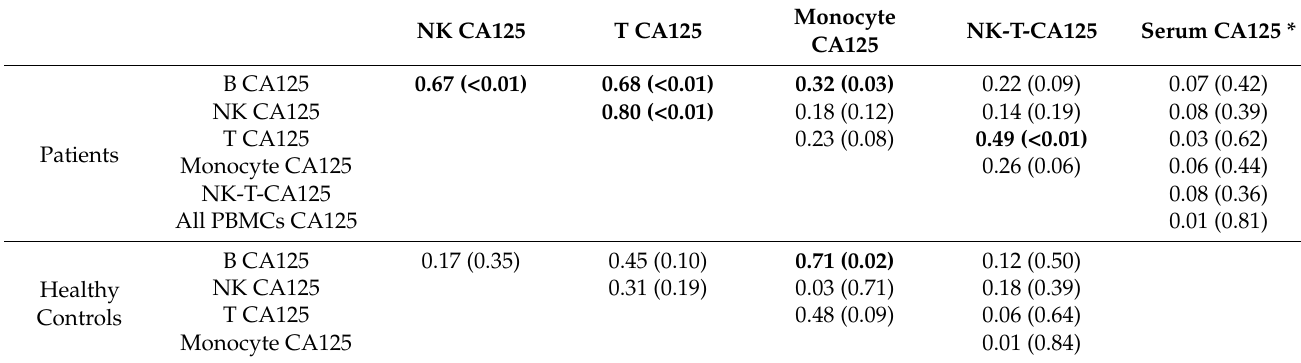
Table 3. Correlation coefficients (r 2 ) between the average number of PNPs bound to each leukocyte subtype on 14 serous ovarian cancer patients and 7 healthy controls. The last column represents the correlation to Serum CA125 for the 12 patients with available serum data. Highlighted in bold are statistically significant correlations ( p <